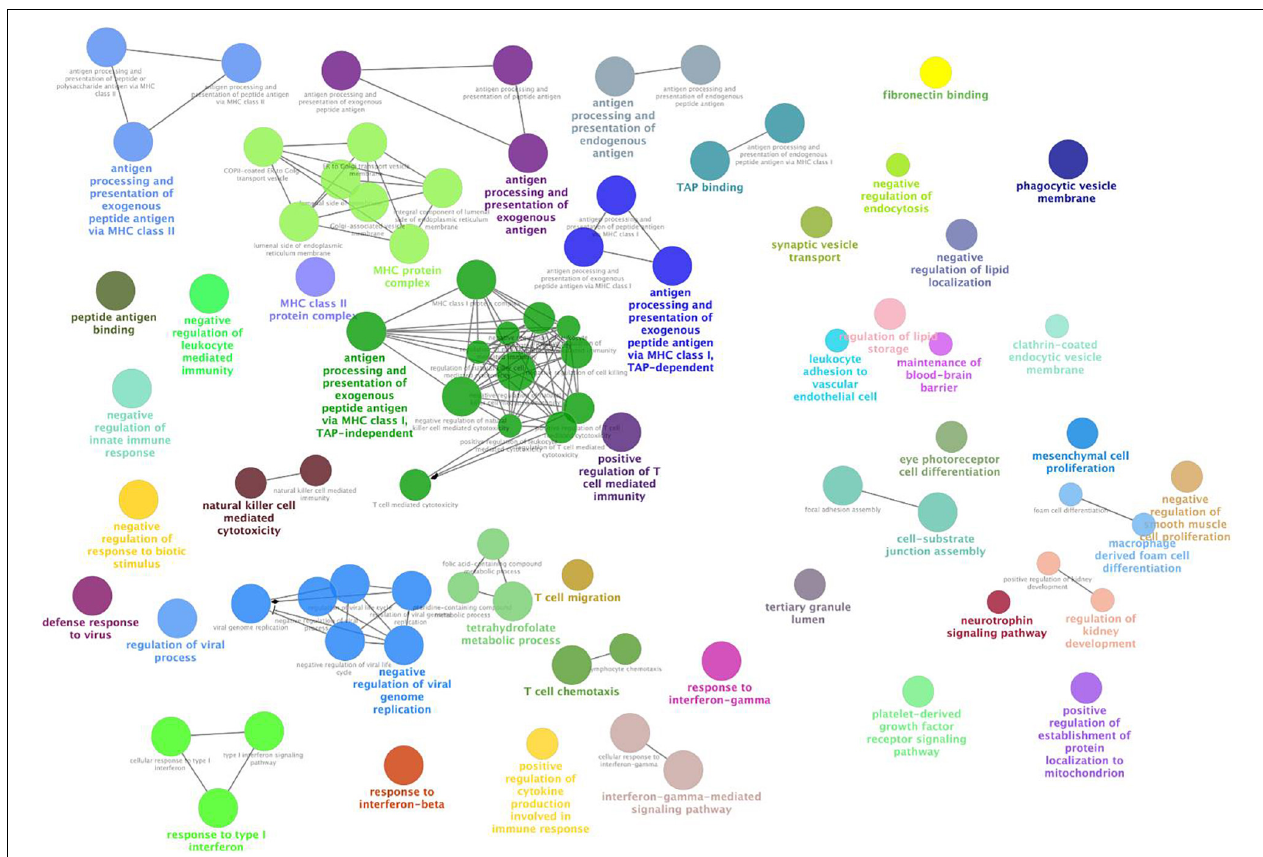
FIGURE 3 | Functional GO groups enriched by genes in non-preserved co-expression modules. This figure illustrates the functionally grouped network that constructed by GO terms (nodes) that associated to non-preserved co-expression module genes. The size of the nodes reflects the statistical significance of the terms. The degree of connectivity between terms (edges) is calculated using kappa statistic and functional groups are defined using the kappa score. The name of the group is given by the most significant term in the group and nodes in the same group are represented with same